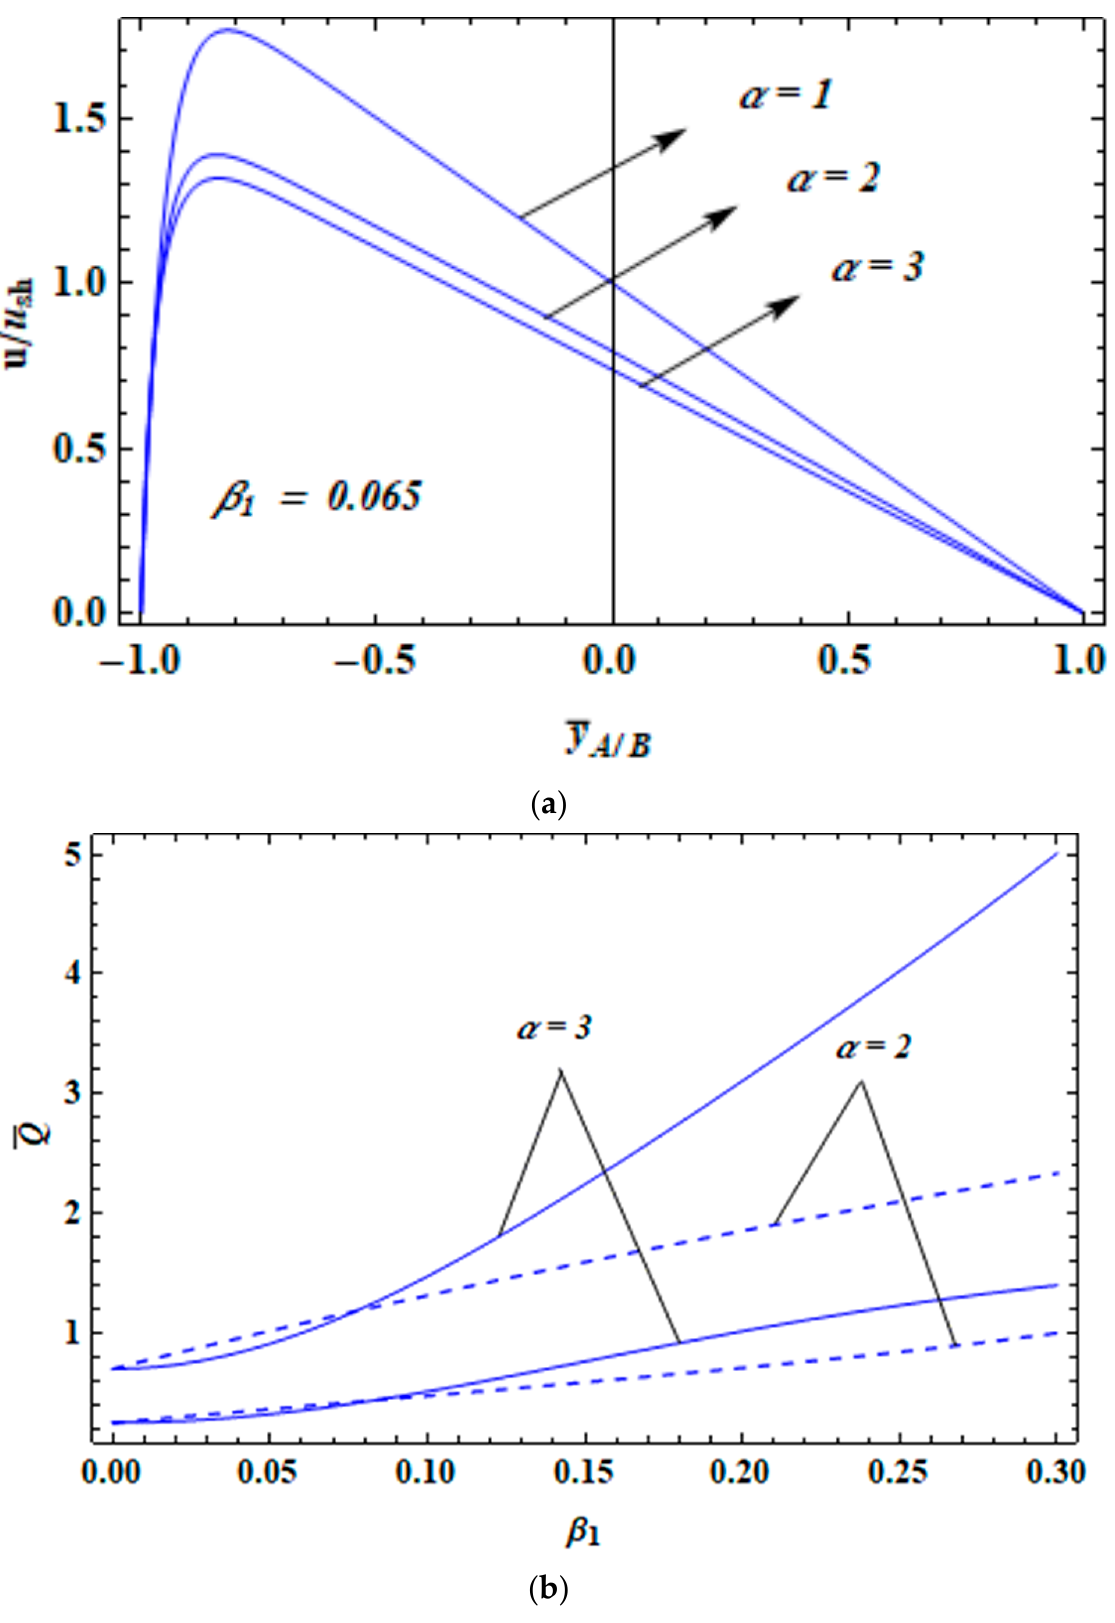
= 0.2; 𝑘 = 20; 𝑅 = 0; ( b ) 𝛽 = 1; 𝛤 = 0; 𝑅 Figure 6. ( a ) β = 1; Γ = 0; R A = 0.2; k = 20; R ζ = 0; ( b ) β = 1; Γ = 0; R A = 0.2; k = 20; R ζ = (cid:3002) (cid:3085)